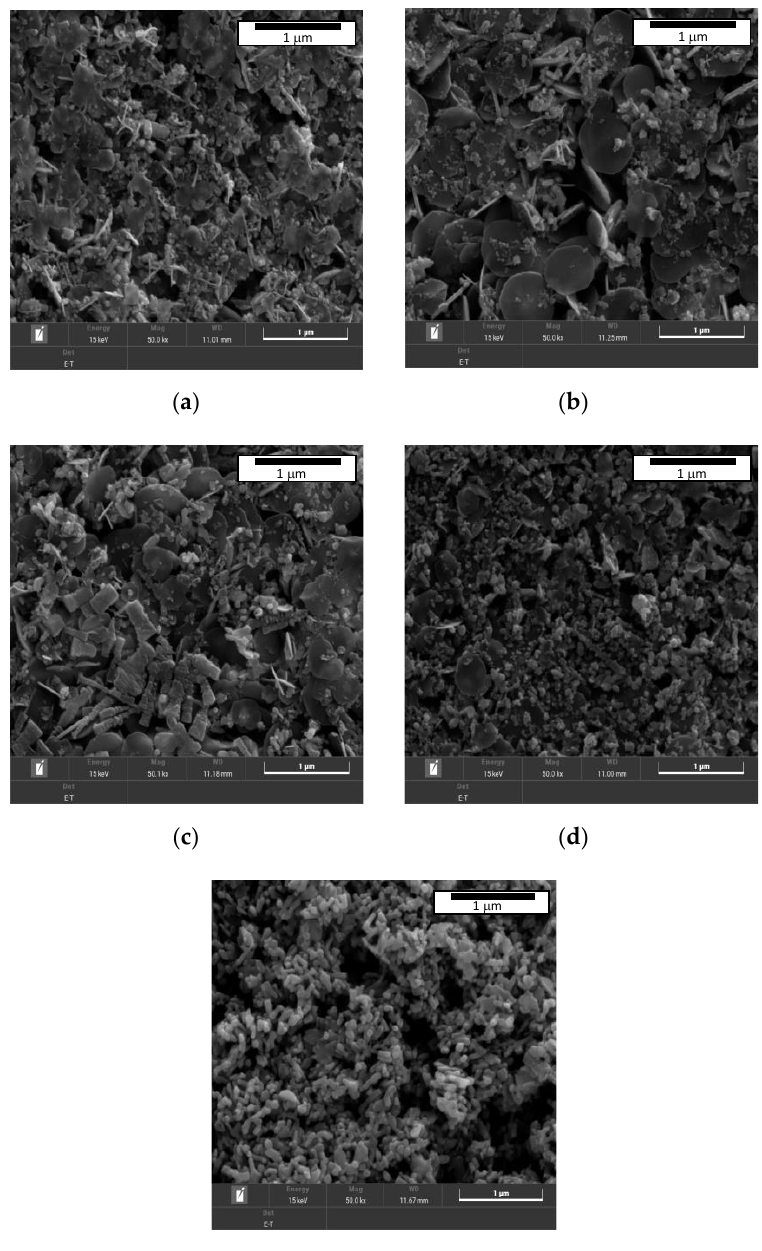
Figure 3. SEM image of ZnO-CuO/water hybrid nanofluid with magnifications of 50 k × mixed at ratio of ( a ) 10:0, ( b ) 7:3, ( c ) 5:5, ( d ) 3:7, ( e ) 0:10.